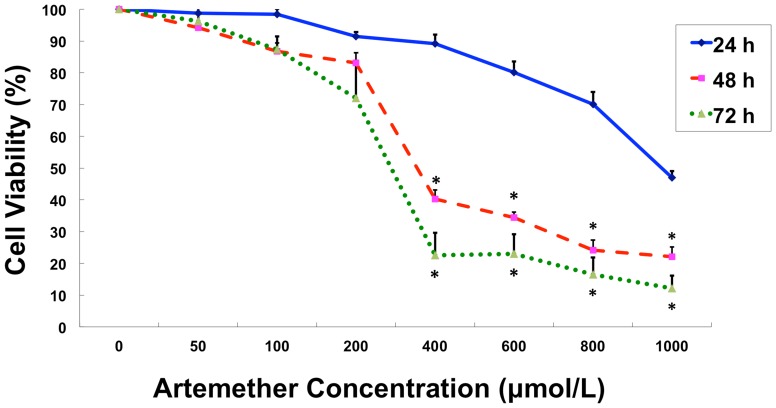
The effects of Artemether on the proliferation of U87 cells.Artemether inhibited the proliferation of U87 cells in time- and dose-dependent manners. U87 cells were treated with artemether at various concentration levels (0, 50, 100, 200, 400, 600, 800 and1000 µmol/L) for 24–72 h. 48-hour and 72-hour groups showed significant inhibitory effects on proliferation compared with the 24-hour group. Artemether inhibited the proliferation of U87 cells significantly at 400 µmol/L for 48 h or 72 h. Nevertheless, no significant difference was seen between 48-hour and 72-hour groups. n = 3. *P<0.01 (compared with 0 µmol/L group and 24-hour group).